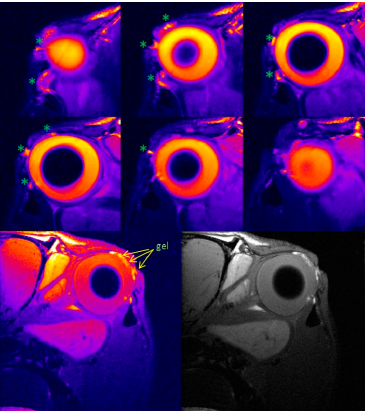
Figure 7. MRI of the rat eye rat 2 h after instillation of ion-sensitive hydrogel indicate the hyperintense signals caused by hydrogel. Reproduced with permission from [110], published by Elsevier, 2015.